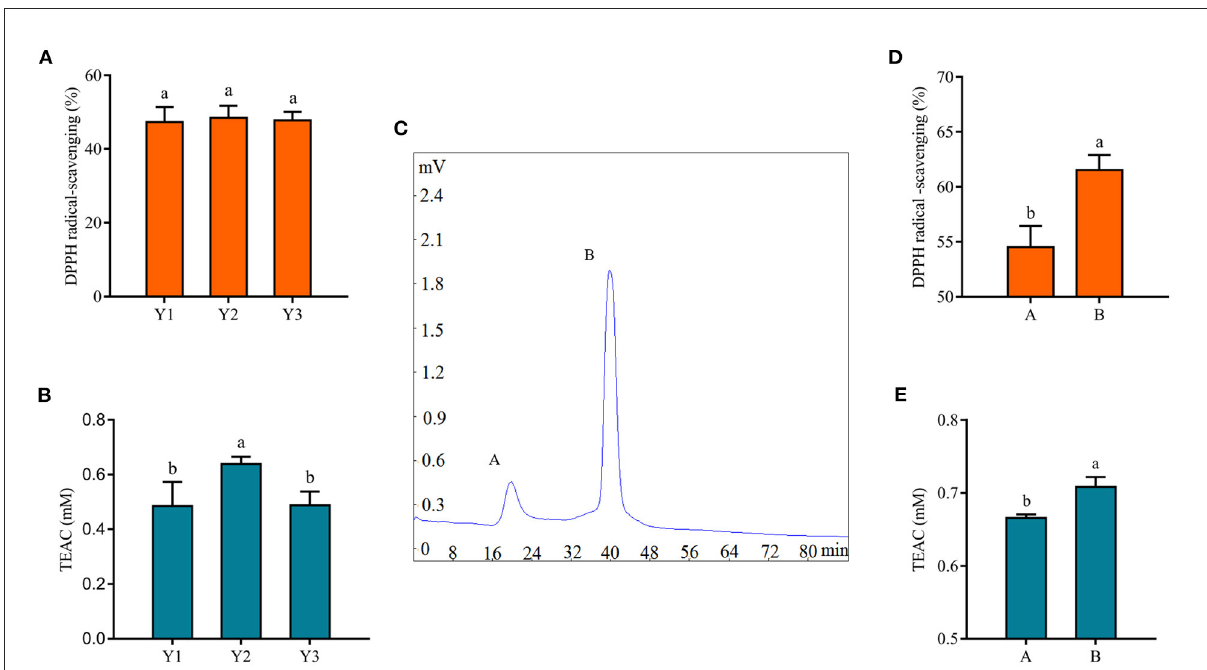
FIGURE3 Isolation of antioxidant peptides from fermented yogurt. The DPPH radical scavenging ability (A) and TEAC (B) of each fraction are separated by centrifugal ultrafiltration. (C) Gel chromatogram of component Y2. The DPPH radical scavenging ability (D) and TEAC (E) of component Y2 are separated by centrifugal ultrafiltration. Different lowercase letters indicate significant differences between groups ( p <